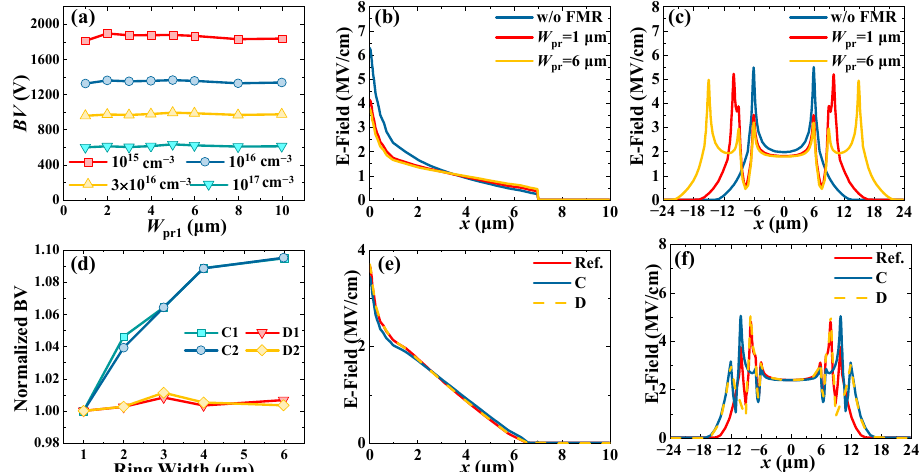
Figure 6. Relationship between breakdown voltage and FMR width. ( a – c ) Single FMR, ( a ) FMR width has little effect on the breakdown voltage; ( b , c ) Electric field distribution at 810 V, ( b ) vertical profile, and ( c ) lateral profile. ( d – f ) Double FMRs; ( d ) the inner FMR width has a greater effect on the breakdown voltage; ( e , f ) electric field distribution at 810 V; ( e ) vertical profile; and ( f ) lateral profile.